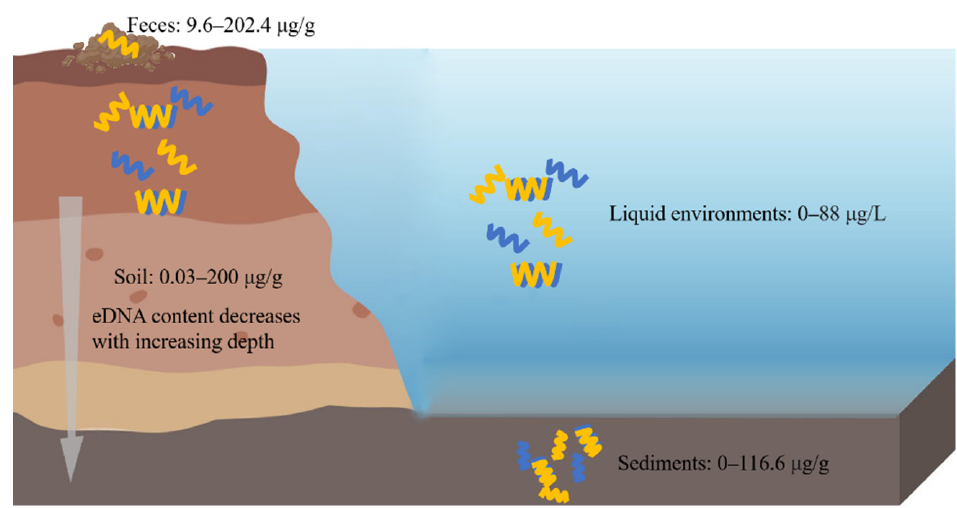
Figure 3. eDNA in different ecological environments. eDNA is widely distributed in soil, sediments, feces, and liquid environments. The left side of the picture represents the soil, and above the soil are the feces, and on the right side of the picture are the liquid environments, and under these is the sediment.